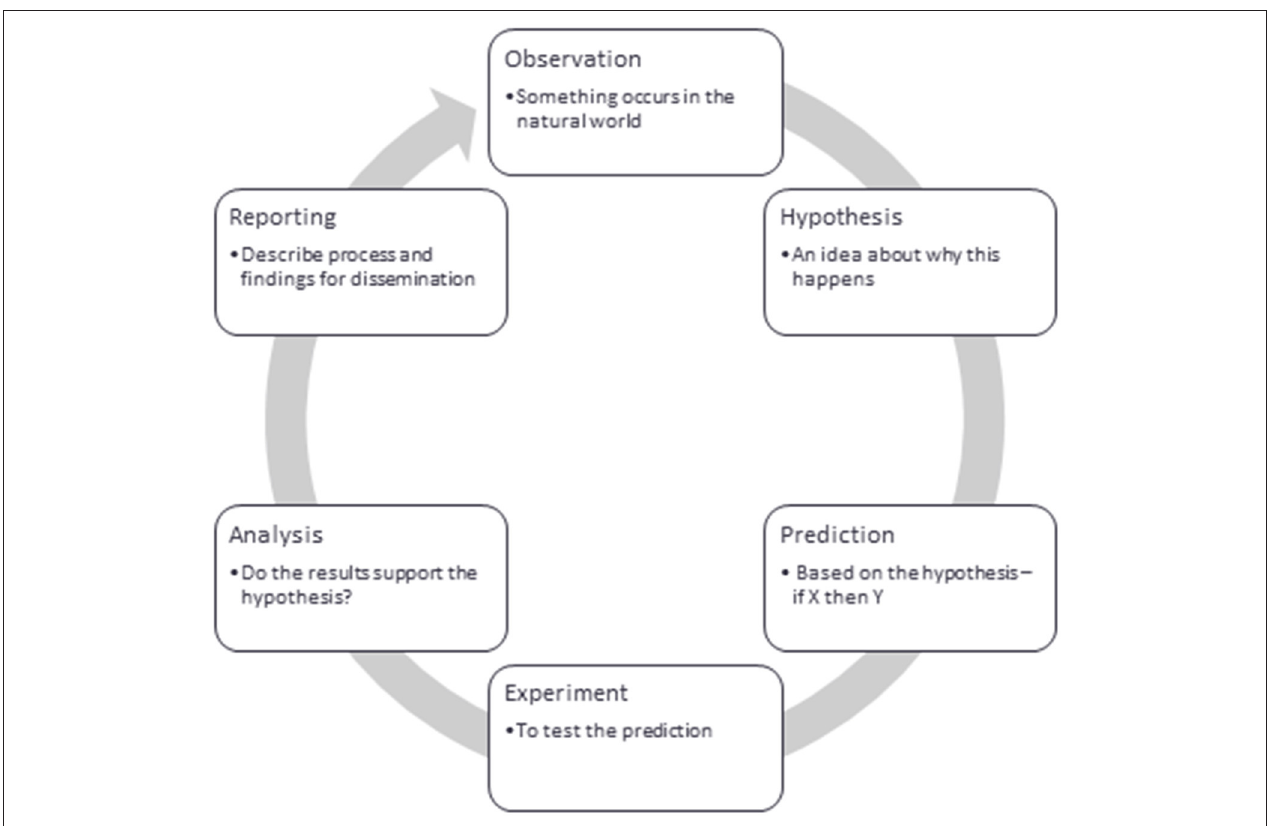
FIGURE 1 | A generalized outline of the hypothetico-deductive model for scientific